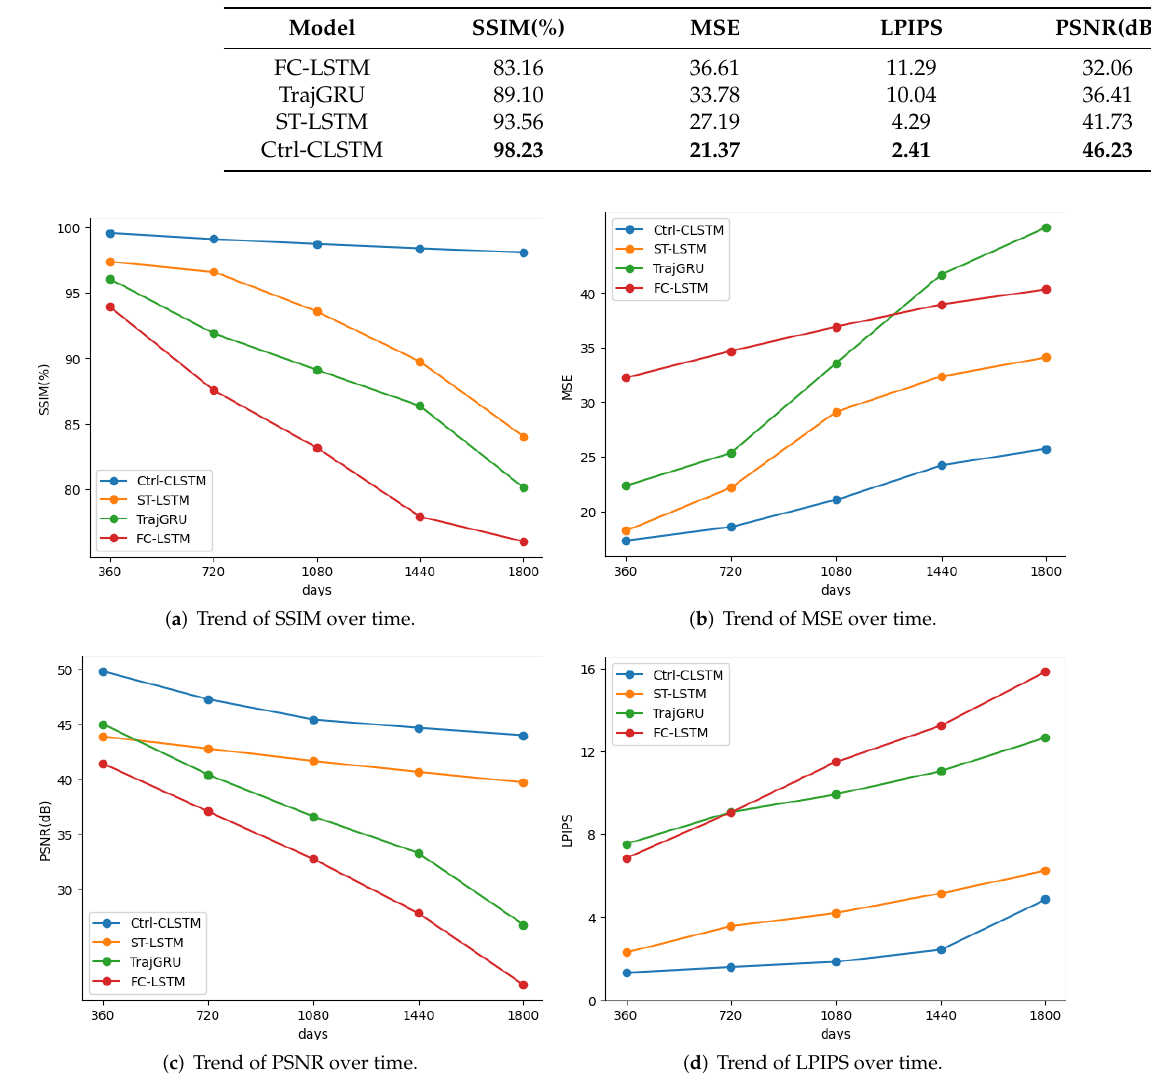
Figure 6. Prediction effects over time.